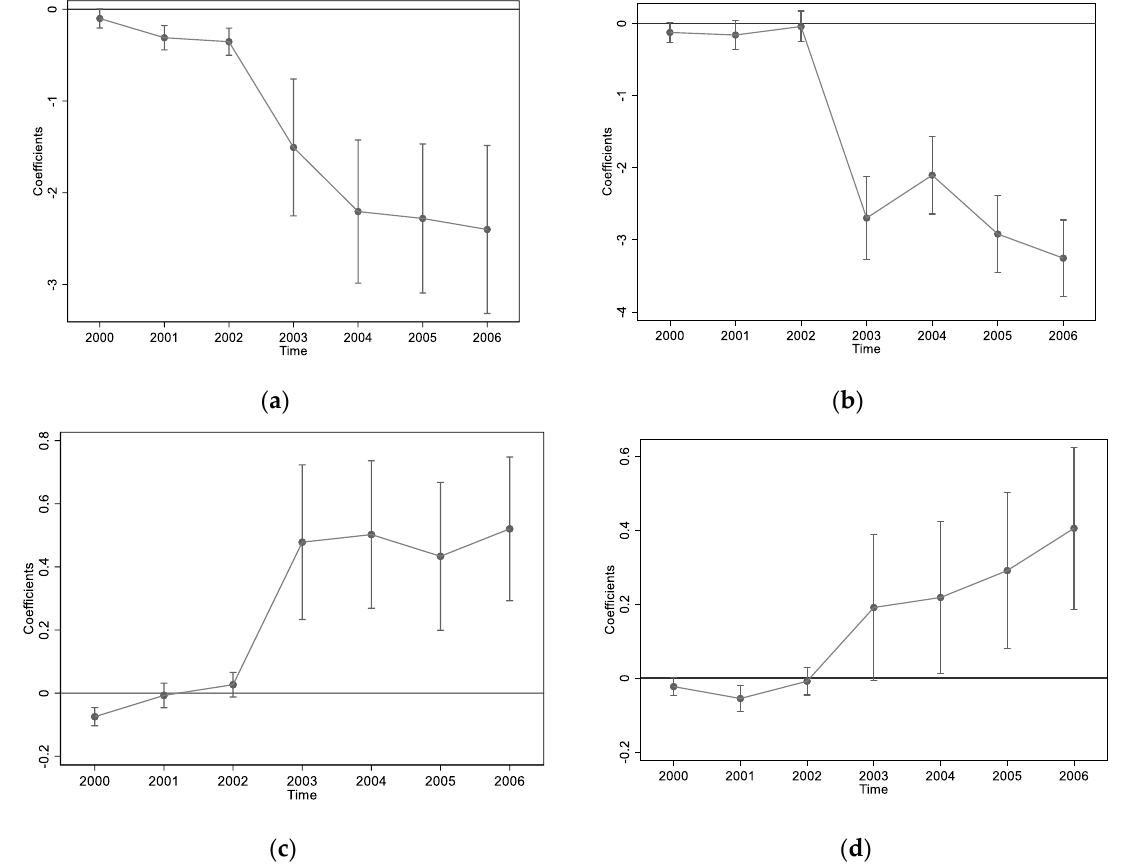
Figure 2. Parallel trend test: ( a ) coefficient trend of COD ; ( b ) coefficient trend of SO 2 ; ( c ) coefficient trend of TFP_OP ; ( d ) coefficient trend of TFP_LP.